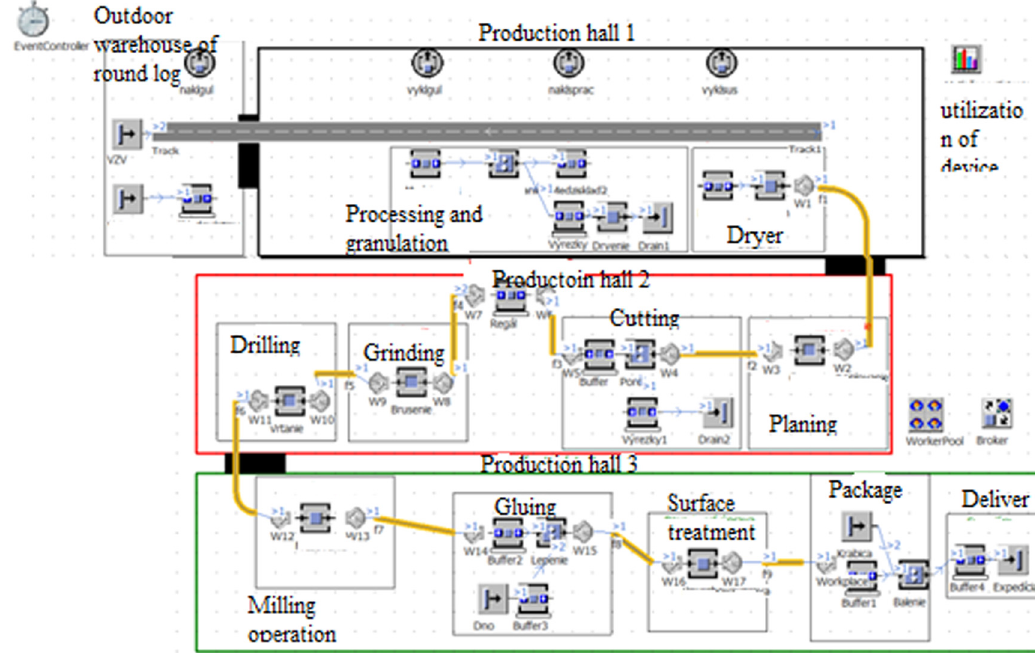
Figure 3: Production process of the enterprise presented in the program Tecnomatix Plant Simulation. Source: authors.